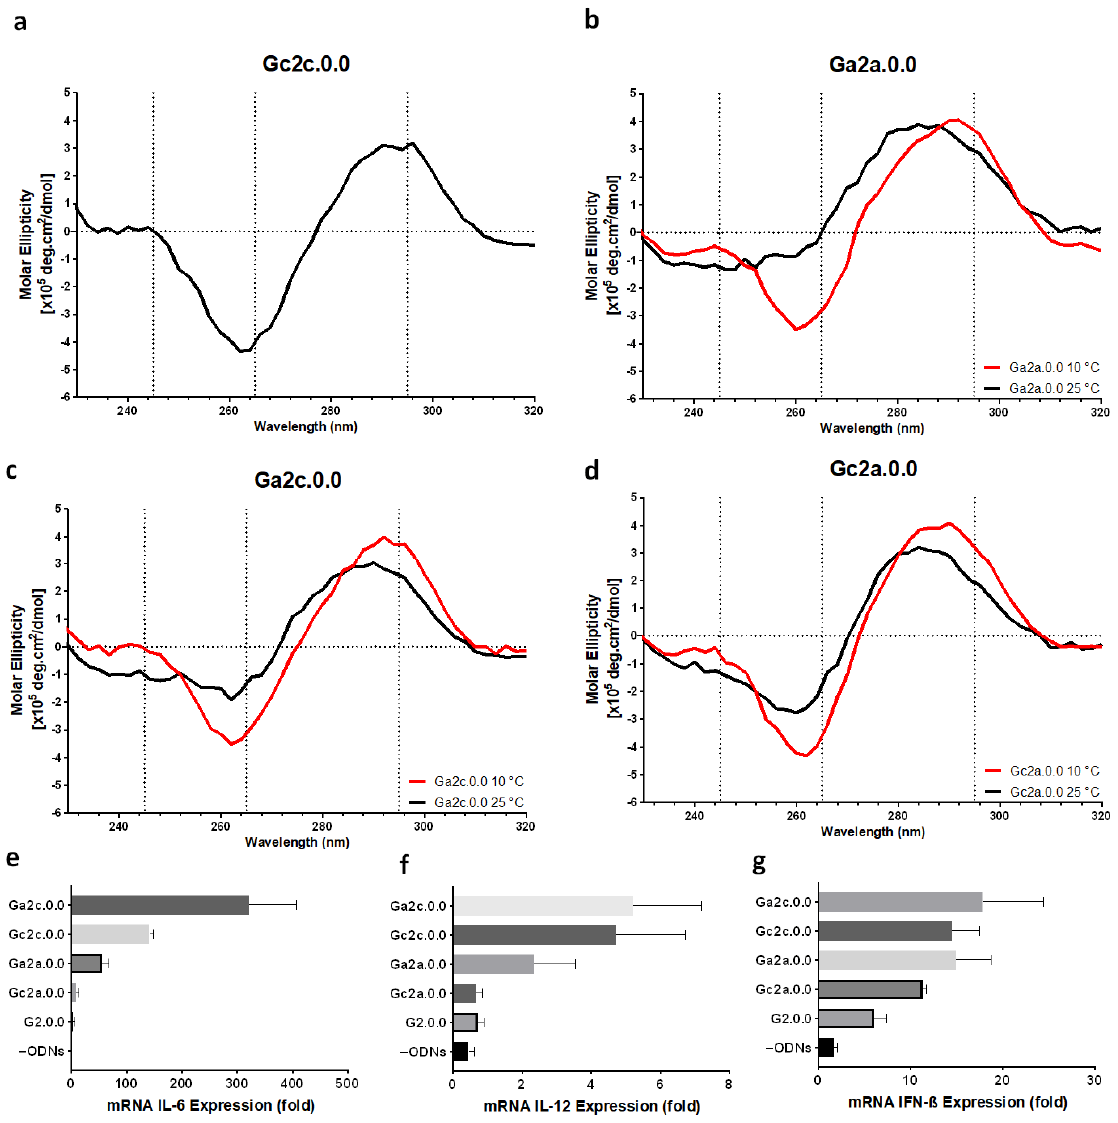
Figure 4. Effect of flanking sequence between the CpG motif and G ‐ tetrad in the first loop on antiparallel G ‐ quadruplex formation and cytokine induction. Circular dichroism spectra of ( a ) Gc2c.0.0, ( b ) Ga2a.0.0, ( c ) Ga2c.0.0, and ( d ) Gc2a.0.0 at 25 °C (black line) or 10 °C (red line) were observed. Relative expression level of ( e ) IL ‐ 6, ( f ) IL ‐ 12, and ( g ) IFN ‐ ß mRNA transcription in RAW264 cells stimulated by G2.0.0, Ga2a.0.0, Gc2c.0.0, Ga2c.0.0, and Gc2a.0.0. –ODNs indicate RAW264 cells with only D ‐ PBS buffer added. Data are presented as the mean ± SD ( n = 5).